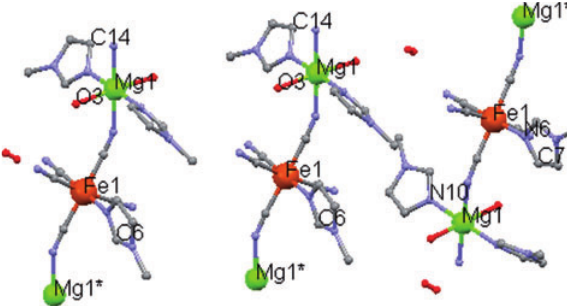
Figure 1 View of the structure of (1-Meim)(NC)